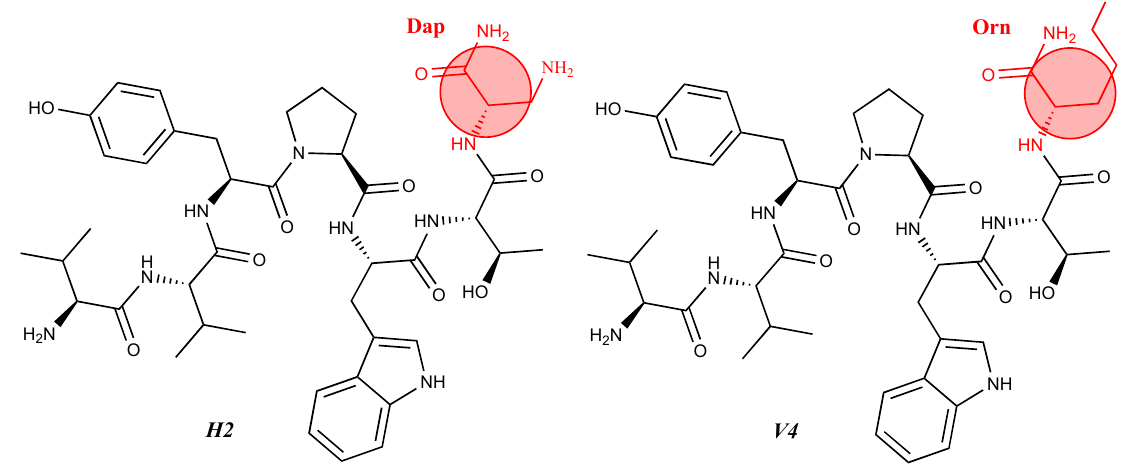
Figure 4. Chemical structure of H2 and V4 peptide analogs.